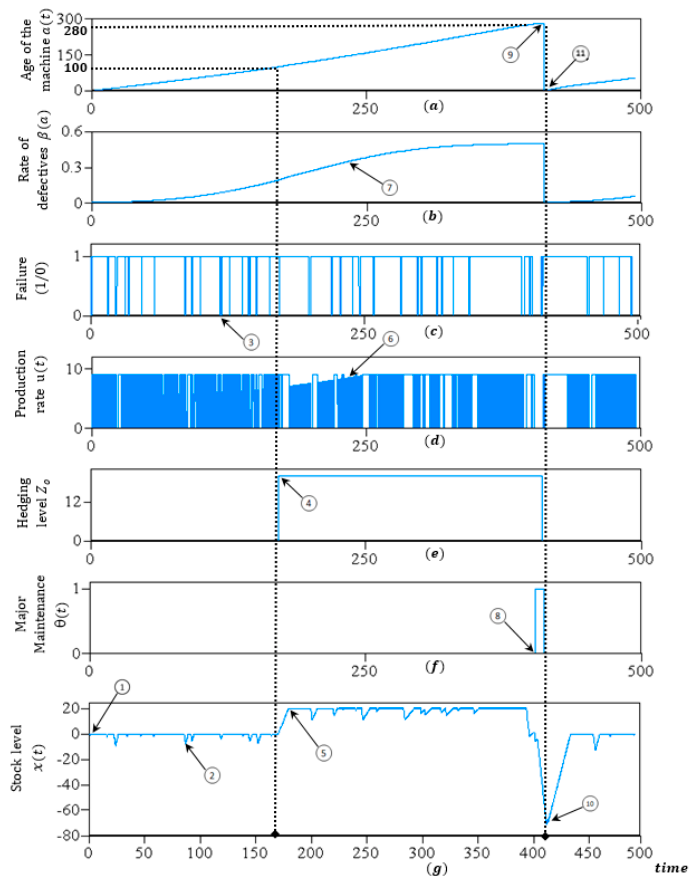
Figure 2. Validation of the simulation model.